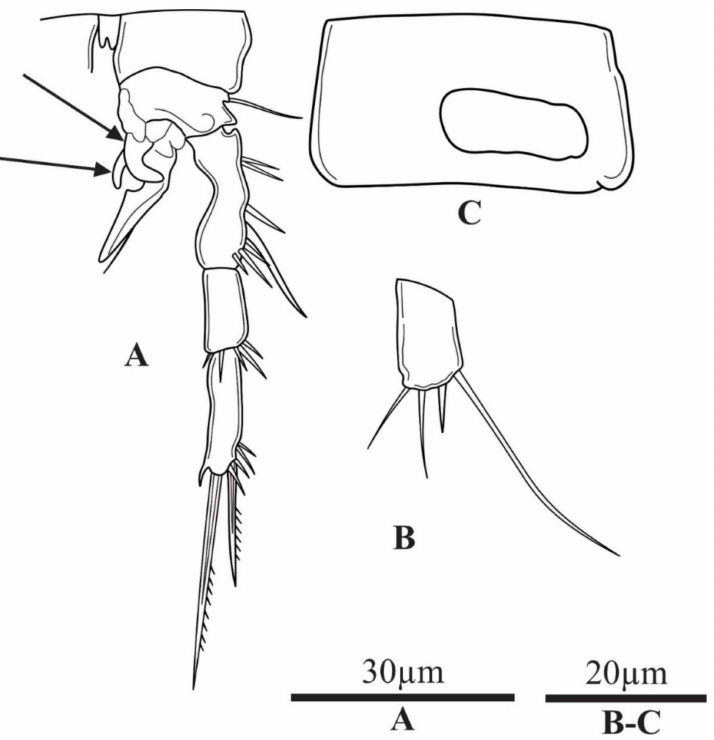
Figure 9. Parastenocaris sontraensis sp. nov. male. ( A ), P4; ( B ), P5; ( C ), P6. The arrows indicate outgrowth on